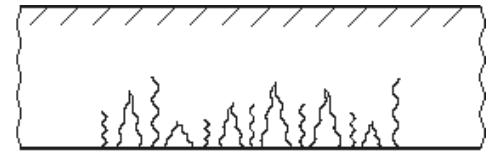
Fig 2. Expansion of cracks through imperfection in crystal lat- tices of metal of object